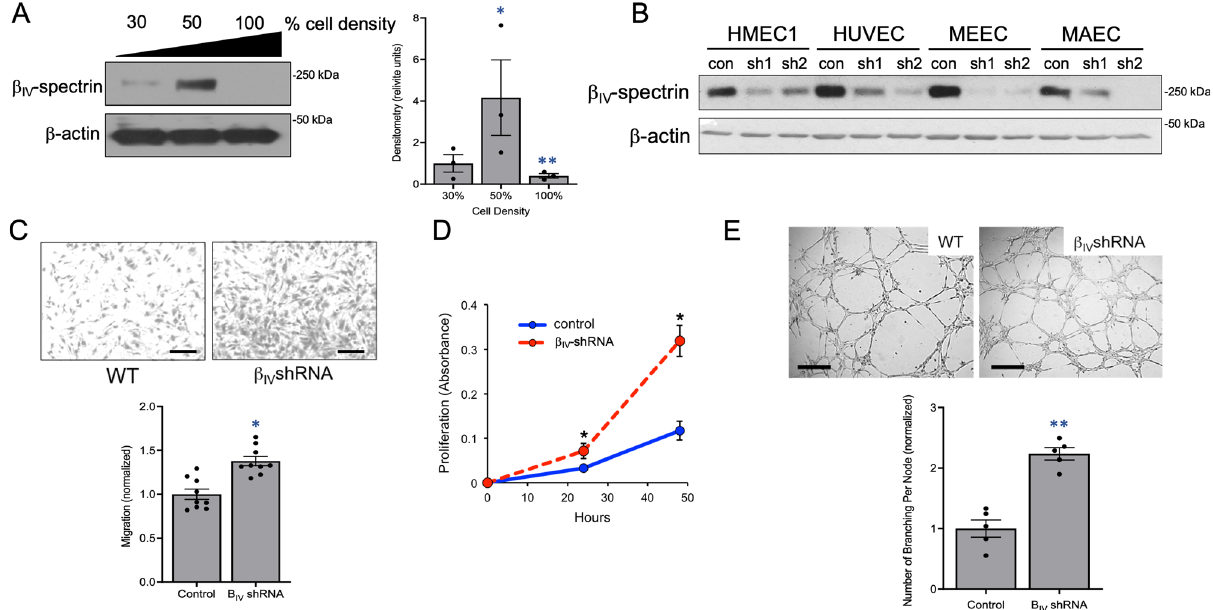
Fig. 1 β IV -spectrin expression in ECs and its regulation of vascular sprouting. A Western blot and densitometry quanti fi cation show endogenous n = 3 independent experiments. Each densitometry value was normalized by the β IV -spectrin expression in MEECs at the designated cell densities, where mean value of the 30% mean and then expressed as a fold change over the 30% value. Error bars represent SEM and type 2 t -test results show: * p = 0.04, ** p = 0.02 relative to 30% cell density. Source data are provided as a Source data fi le. B Western blot shows endogenous β IV -spectrin expression and its knockdown using two distinct shRNA target sequences in human microvascular EC 1 (HMEC1) and human umbilical vein EC (HUVEC) along with MEEC and primary mouse aortic ECs (MAEC) ECs. C Representative images of transwell migration using WT (control scrambled) and stable knockdown β IV - shRNA MEECs where n = 9 regions of interest from 3 independent experiments. Scale bar: 100 μ m. Data are presented as normalized to the WT ± SEM. Type 2 t -test results show relative to control: * p = 0.00001. Source data are provided as a Source data fi le. D Crystal violet assay shows comparison of proliferation between WT and β IV -shRNA MEECs over 48 h. Graph represents normalized average from three independent experiments. Error bars represent SEM and type 2 t- test results show relative to control: * p = 2.77E − 9 . Source data are provided as a Source data fi le. E Matrigel-induced angiogenesis assay shows EC differentiation and branching in WT versus β IV -shRNA MEECs 20 h upon plating. Scale bar: 100 μ m. Data representative of n = 5 regions of interest from 3 independent experiments presented as normalized values to the control. Error bars represent SEM and type 2 t -test results show: * p = 0.000081 relative to control. Source data are provided as a Source data fi